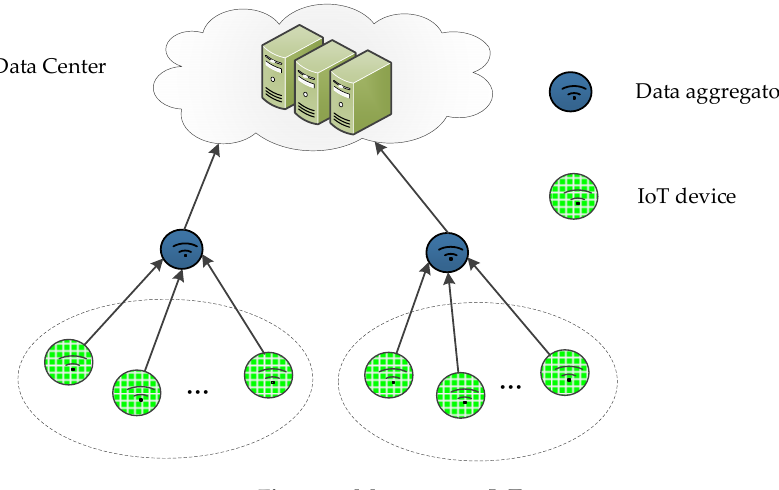
Figure 1. Many-to-one IoT.